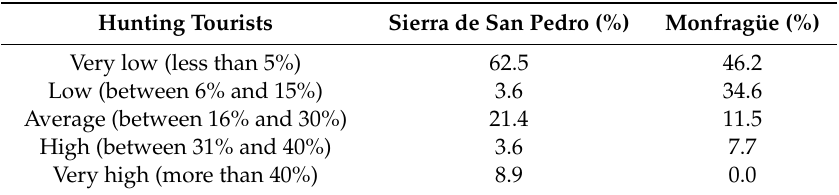
Table 8. Incidence of hunting